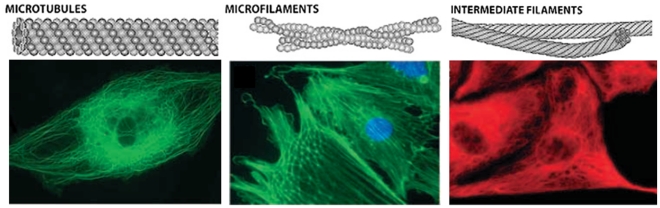
Network of cytoskeletal filaments [5]
, [8].